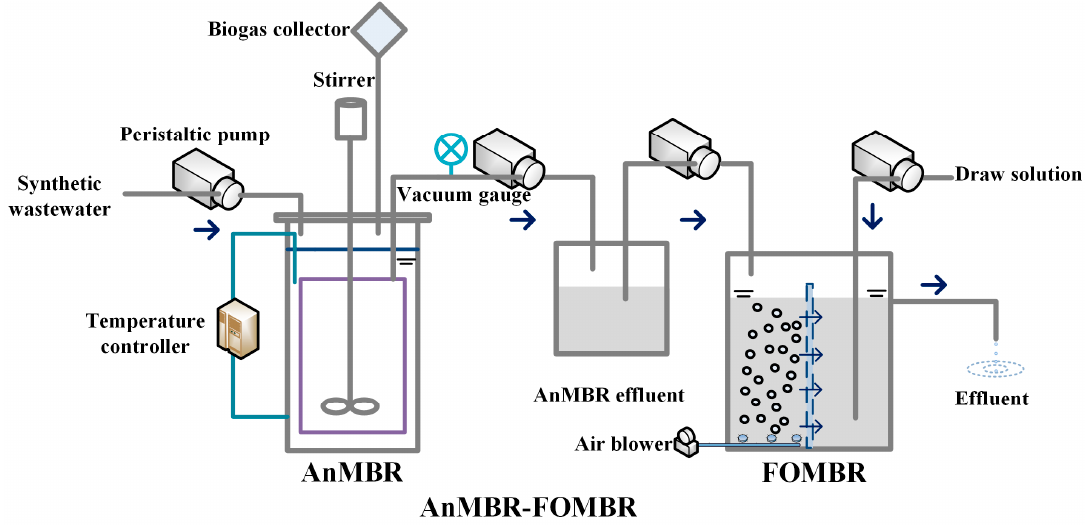
Figure 1. The schematic representation of the combined system consisting of AnMBR and Figure 1. The gas composition ( left ) and the cumulative methane content ( right ) in the high-temperature anaerobic membrane bioreactor (H-AnMBR) and the L-AnMBR. The FOMBR was rectangular (L 300 mm × W 50 mm × H 400 mm) with effective volume of 2.4 L and with a flat-sheet membrane module made of cellulose triacetate (CTA) membranes (Hydration Technologies Inc.). An air diffuser was fixed at the bottom of biological reaction tank for aeration to scour the membrane surface.